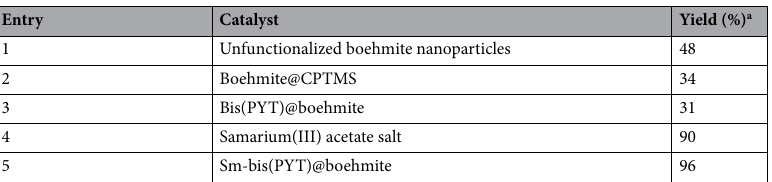
Table 4. Synthesis of 5-phenyl-1H-tetrazole in the presence of boehmite nanoparticles, boehmite@CPTMS, bis(PYT)@boehmite, samarium(III) acetate salt and Sm-bis(PYT)@boehmite. a Reaction